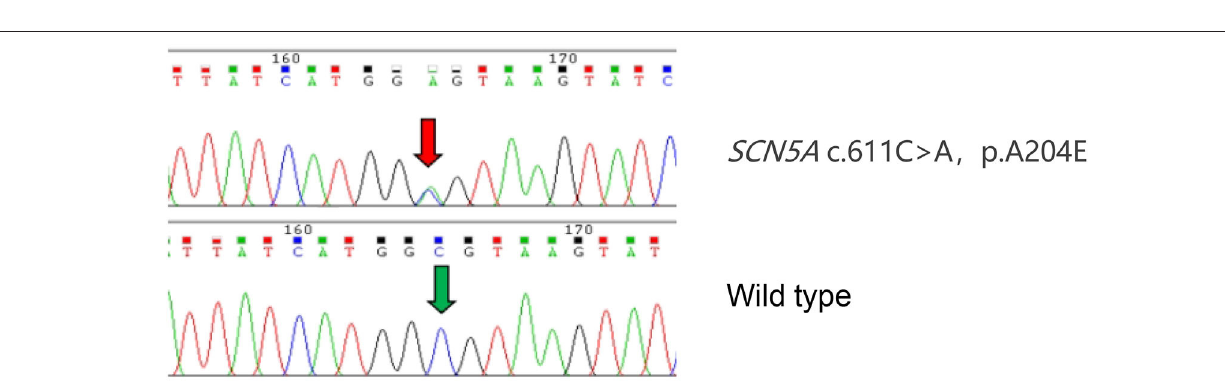
FIGURE 2 | Image of case 1 ( Figure 1 :II-6). (A) Chest X-ray showed congestion with a cardiothoracic ratio of 80%. (B) Echocardiogram revealed an enlarged left ventricle. LVDd, Left ventricular end-diastolic diameter. (C,D) : Electrocardiogram (ECG) comparison between the normal state and frequent premature ventricular contractions.